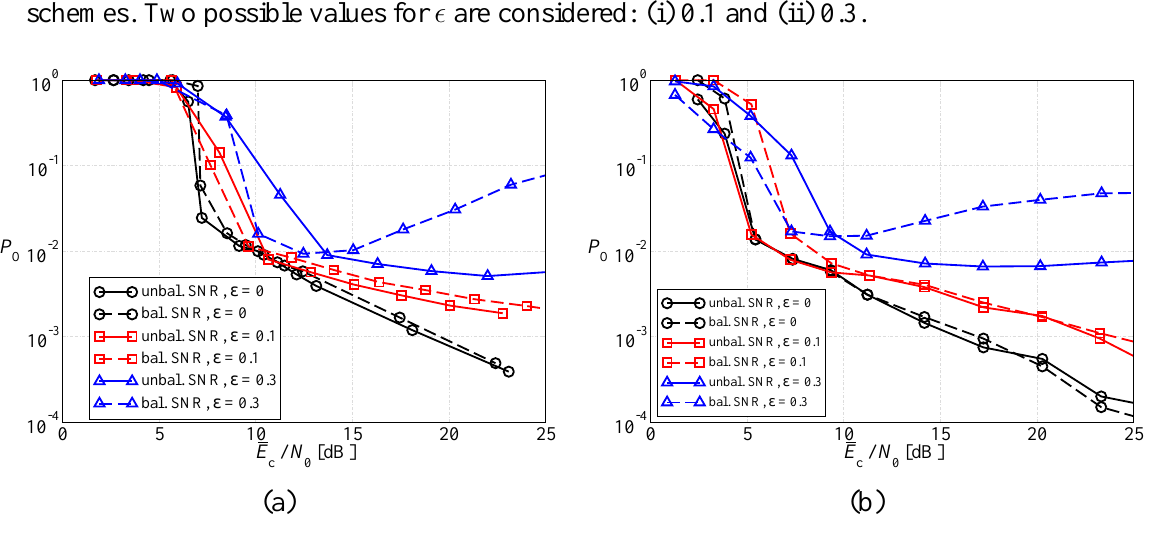
Figure 10. Outage probability, as a function of the average SNR at the sources, in a scenario with non-orthogonal links, considering: (a) DD LDPC-coded schemes and (b) SCCCed schemes. Two possible values for ǫ are considered: (i) 0.1 and (ii)